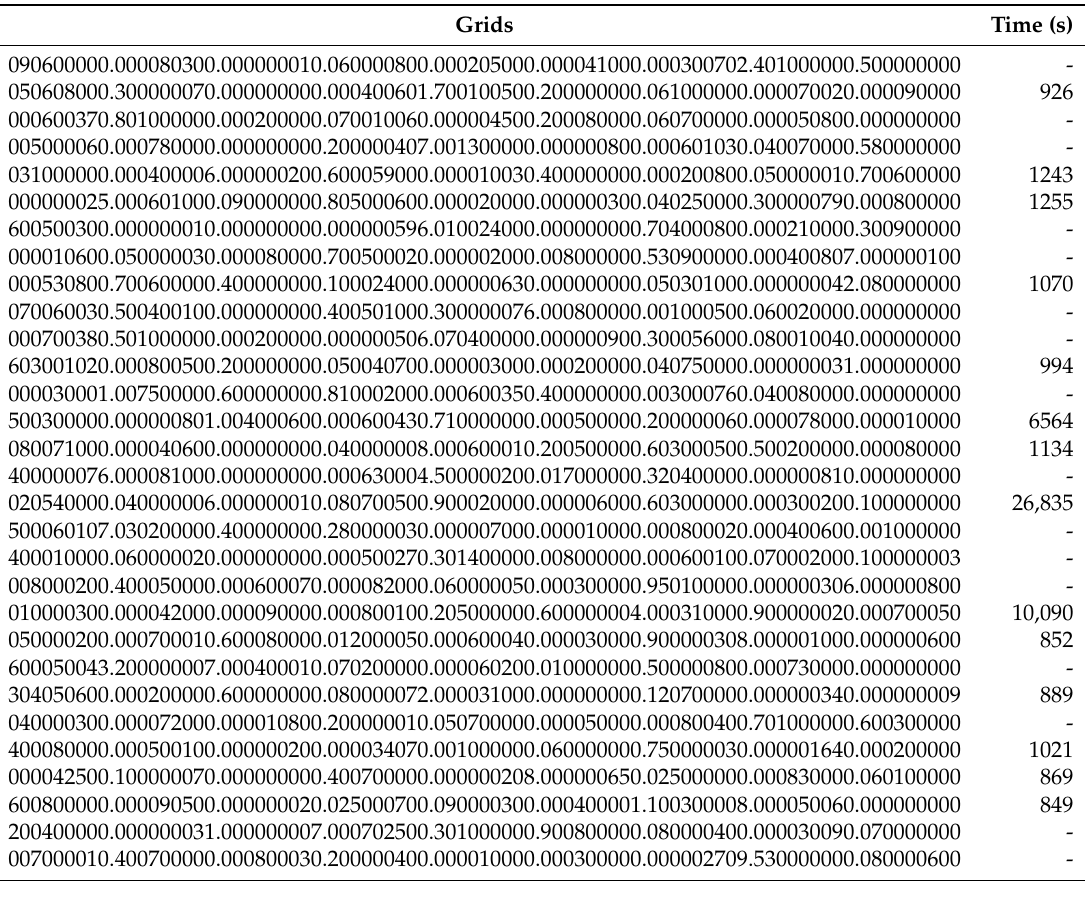
Table A1. The randomly chosen 30 minimum Sudokus and the running times (in s): each sequence of 9 digits is separated by a period, and such 9 sequences in each line represent the rows of a